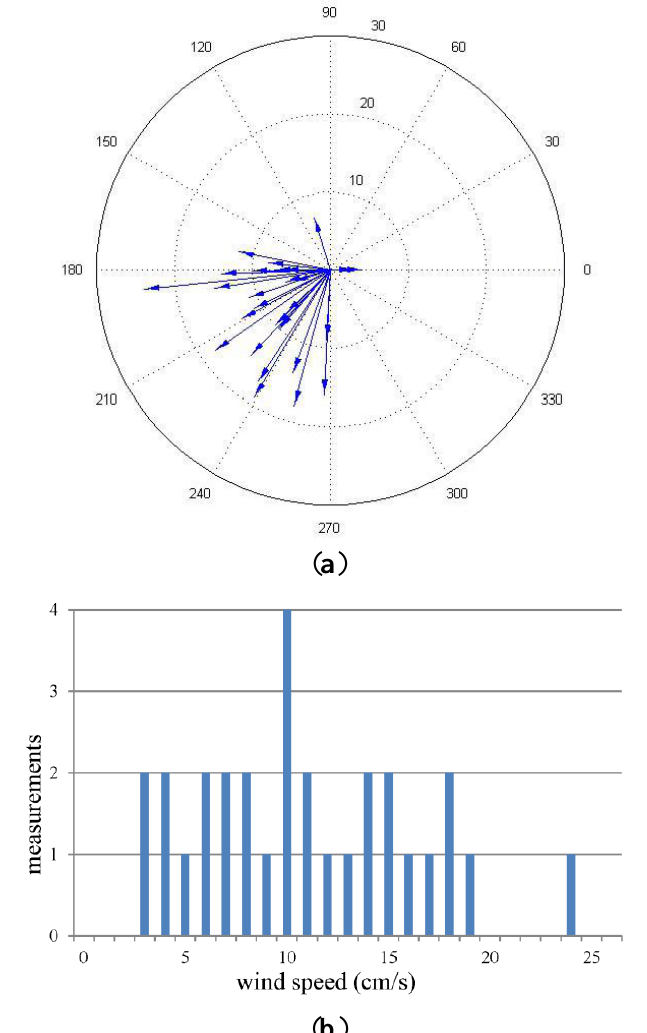
Figure 11. Wind measurements in Arena II recorded by the central anemometer. ( a ) Polar plot measurements recorded by the central anemometer. The arrows‘ directions indicate the directions of the airflow and their lengths indicate the speeds; ( b ) Wind speed histogram for the measurements recorded by the central